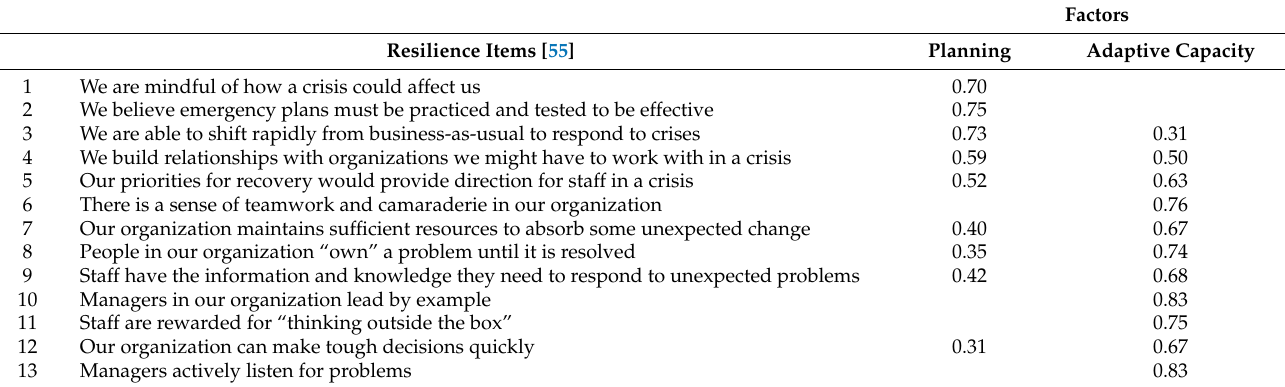
Table 4. Principal factor component analysis of the organizational resilience scale.